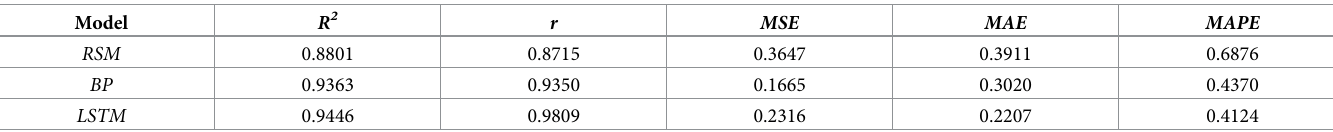
Table 6. Prediction effect of RSM, BP neural network and LSTM neural network on the moisture content of wood fiber ICD.